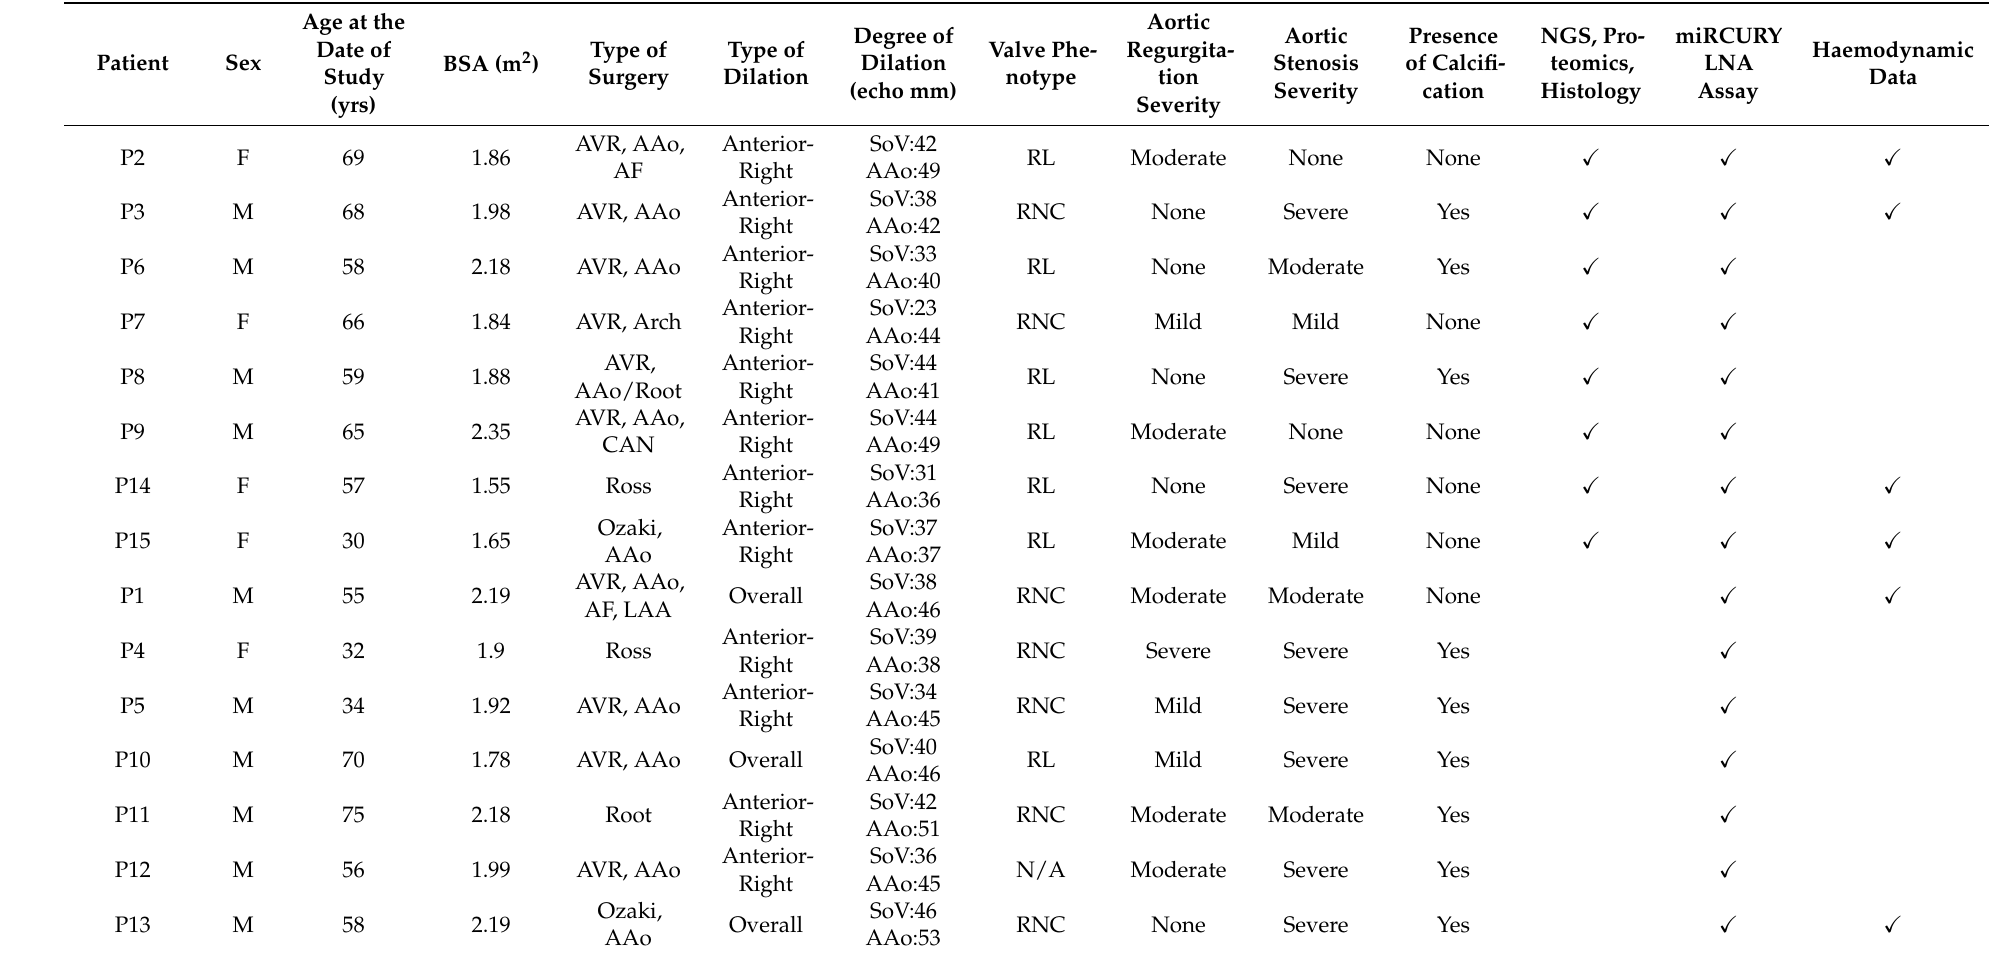
Table 1. Patient population